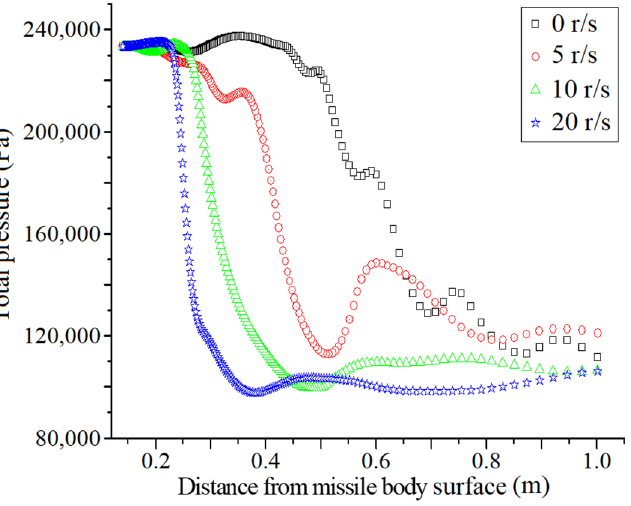
Figure 9. Diagram of total pressure at symmetrical axis of the jet changing with distance from nozzle exit.